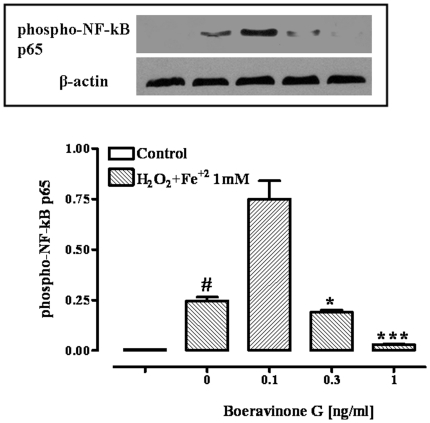
Effect of boeravinone G (0.1–1 ng/ml) on phospho-NF-kB p65 expression.Quantitative analysis and representative western blot analysis of phospho-NF-kB p65 in Caco-2 cells exposed to Fenton's reagent (H2O2/Fe2+ 1 mM) without or with boeravinone G (0.1–1 ng/ml). The results were normalized with anti-βactin antibodies. #p<0.001 vs control (vehicle); *p<0.05 and ***p<0.001 vs H2O2/Fe2+ alone.